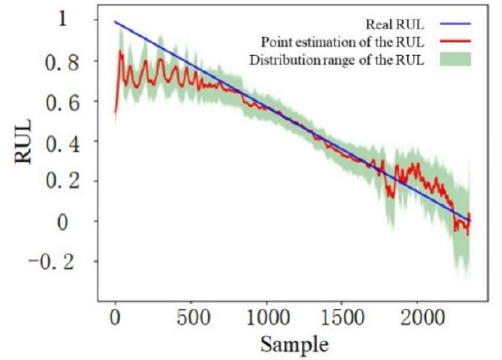
Figure 7. Bearing RUL prediction results.